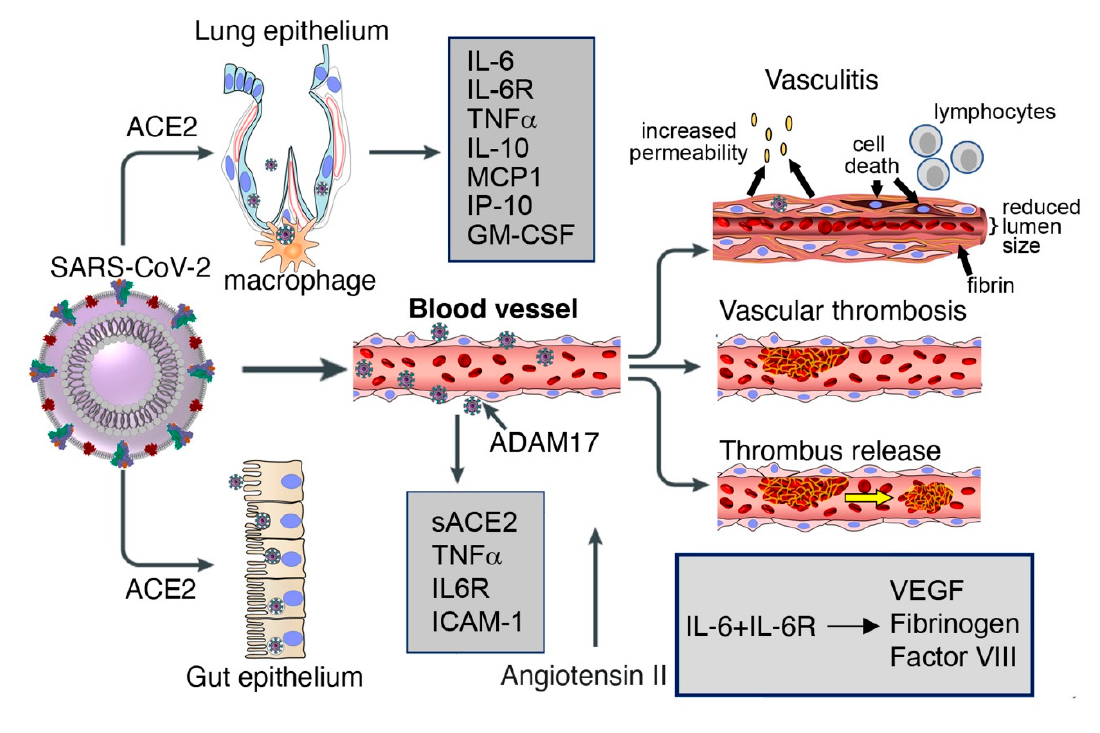
Figure 1. Lung and gut epithelia, macrophages, and vascular endothelia are infected by SARS-CoV-2 in COVID-19. Soluble (s) ACE2, inflammatory cytokines, cytokines receptors, chemokinesand other factors are released by virus binding and cell infection. Vascular pathology in COVID-19 includes vasculitis, associated with endothelial cell death, increased vascular permeability, recruitment of inflammatory lymphocytic cells, fibrin deposition and reduction of lumen size; vascular thrombosis; and vascular embolization.